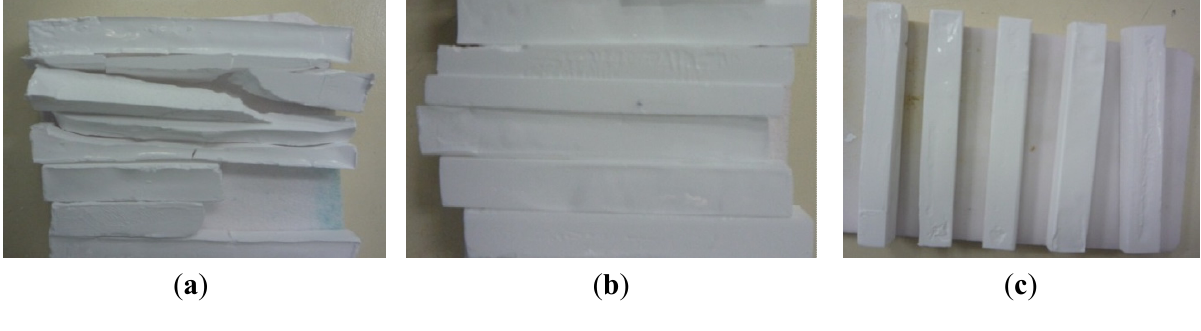
Figure 3. Sintered zirconia-toughened alumina (ZTA) parts after osmotic drying by: ( a ) PEG 400; ( b ) PEG 4000; and ( c ) PEG